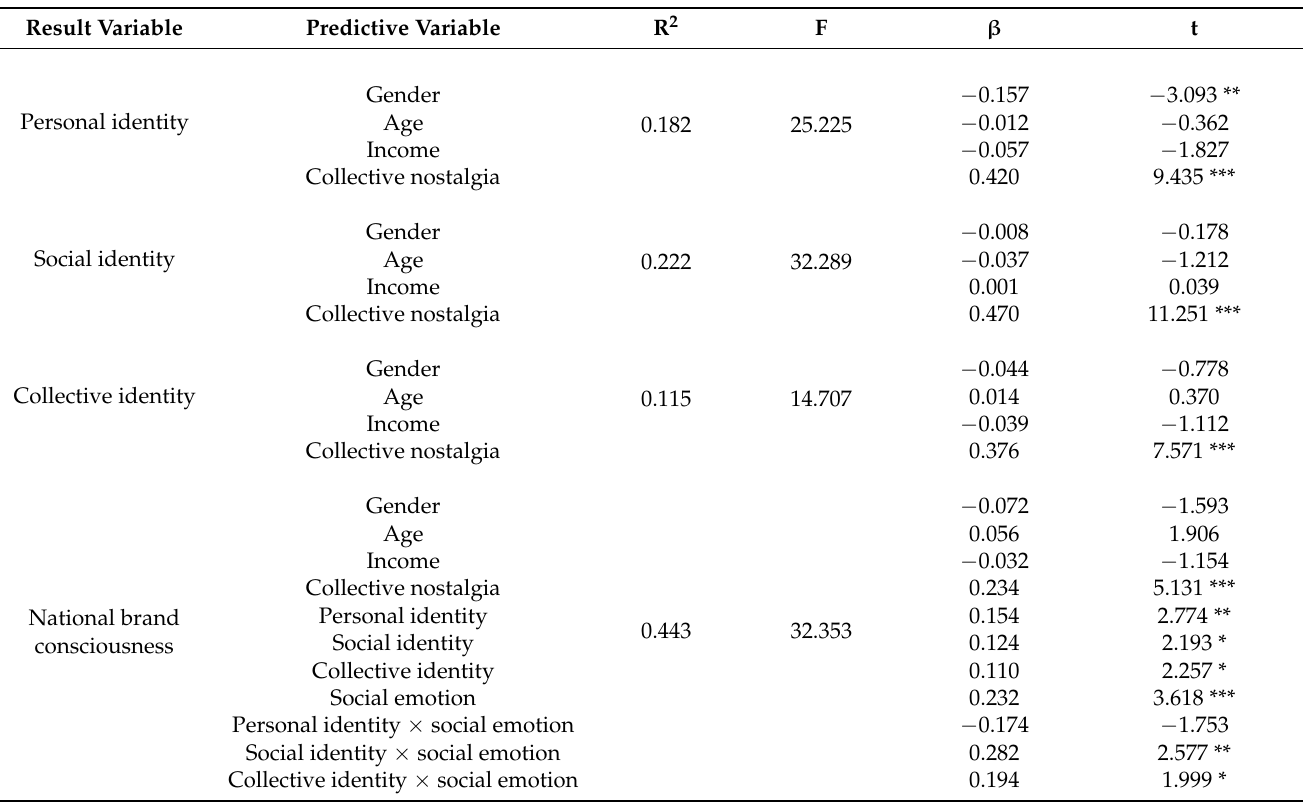
Table 5. Test of the moderating effect of social emotion.